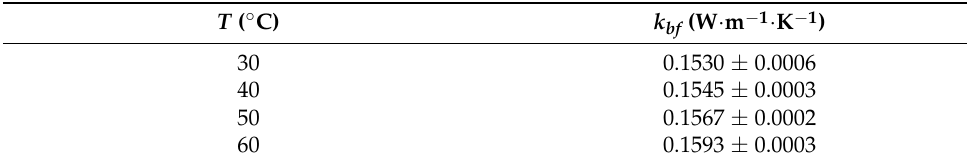
Table 2. Thermal conductivity of the base fluid.